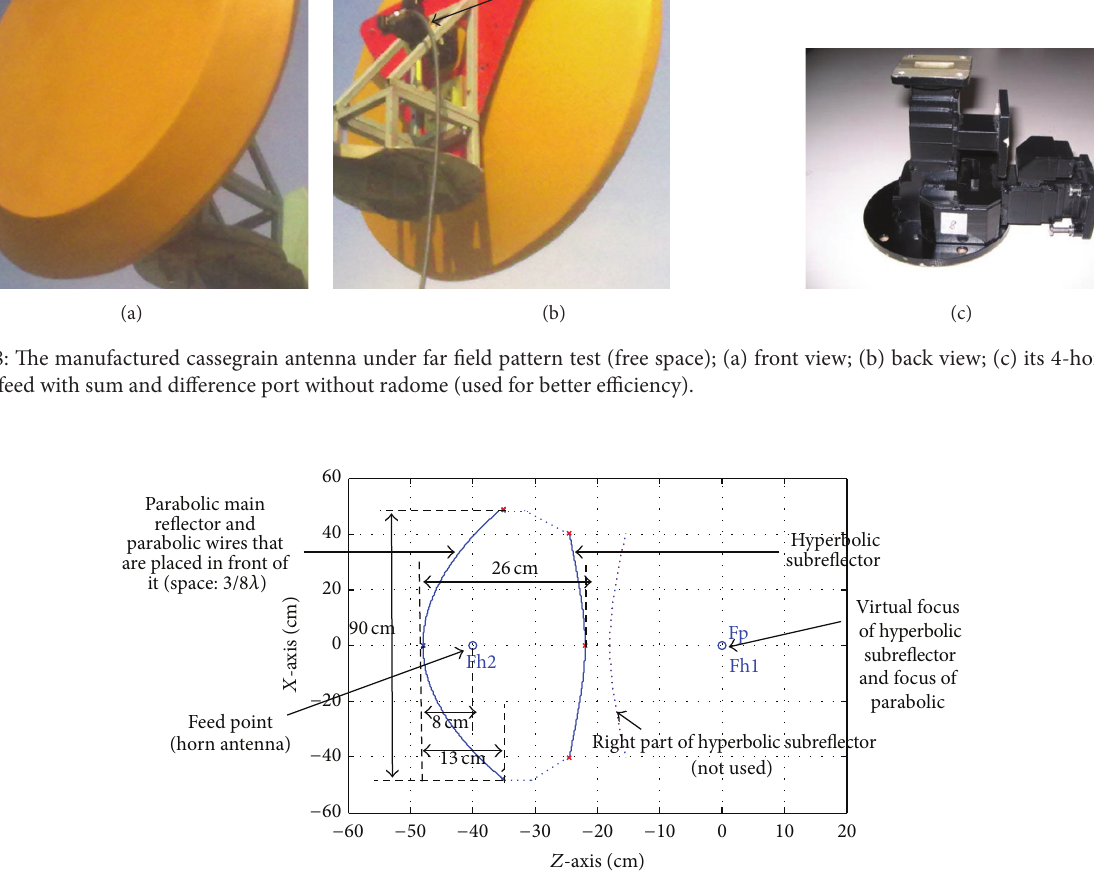
Figure 9: The cassegrain antenna structure and its